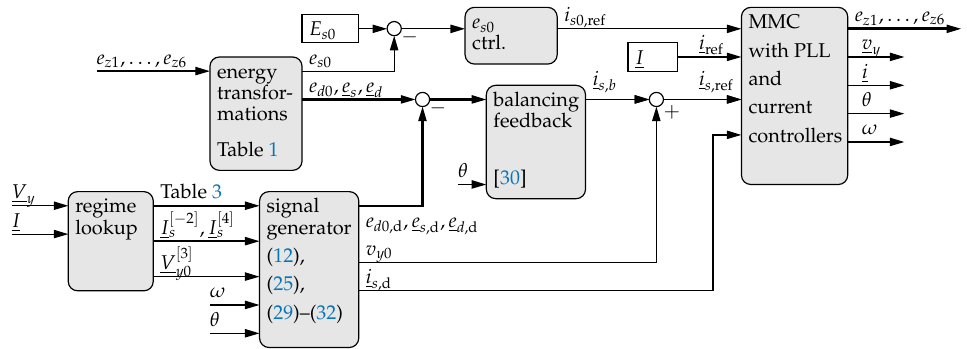
Figure 7. Block diagram of the control scheme for the experiments on a low-voltage